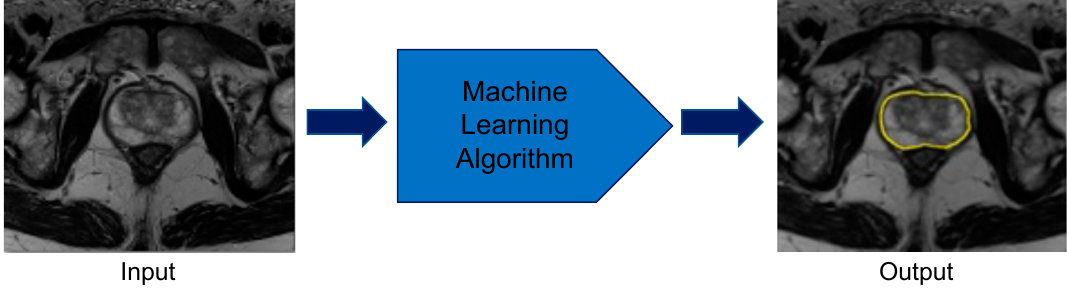
Figure 3. Prostate organ segmentation performed by machine learning methods. The computer takes multiparametric magnetic resonance imaging images as inputs and applies the developed machine learning algorithm to correctly identify the borders of the prostate.